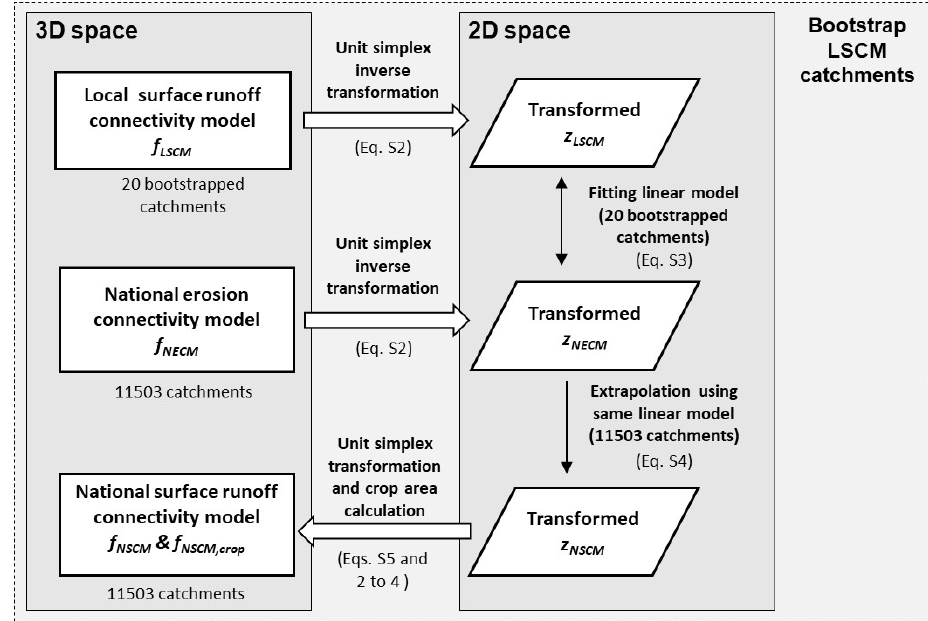
Figure 3. Extrapolation of the local surface runoff connectivity model (LSCM) to the national scale (NSCM) using a unit simplex transfor- mation approach. Equations (2)–(4) are shown in Sect. 2.4.2. Equations (S2)–(S5) are provided in the supplement (Sect.